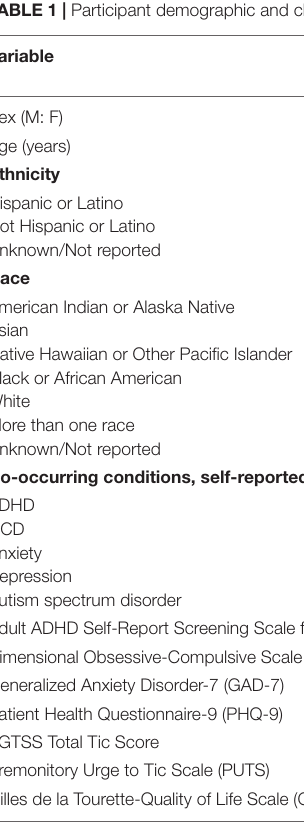
TABLE 1 | Participant demographic and clinical